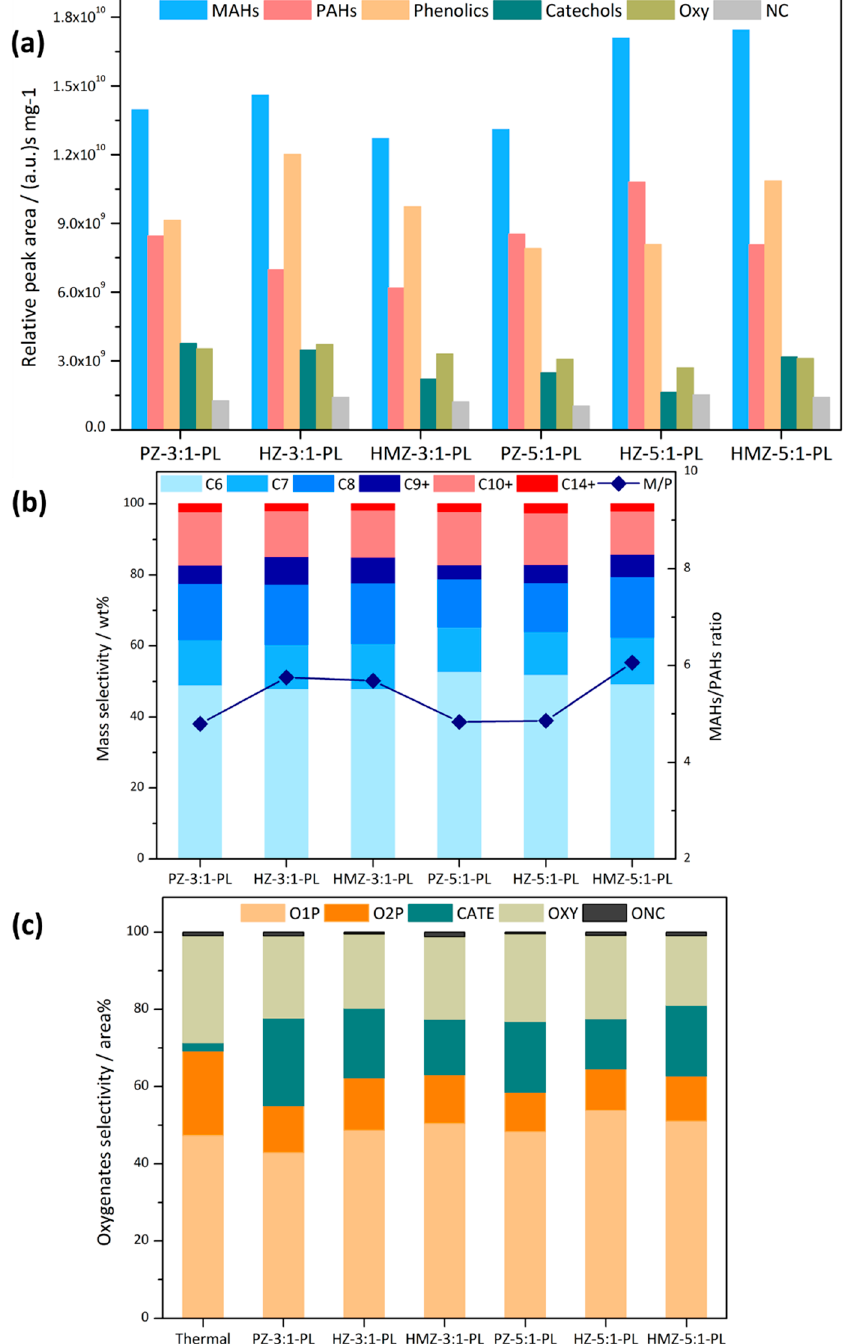
Figure 5. Product distribution of PL CFP. ( a ) Overall distribution based on GC–MS peak area; ( b ) mass distribution of aromatics; ( c ) relative selectivity of oxygenated products.